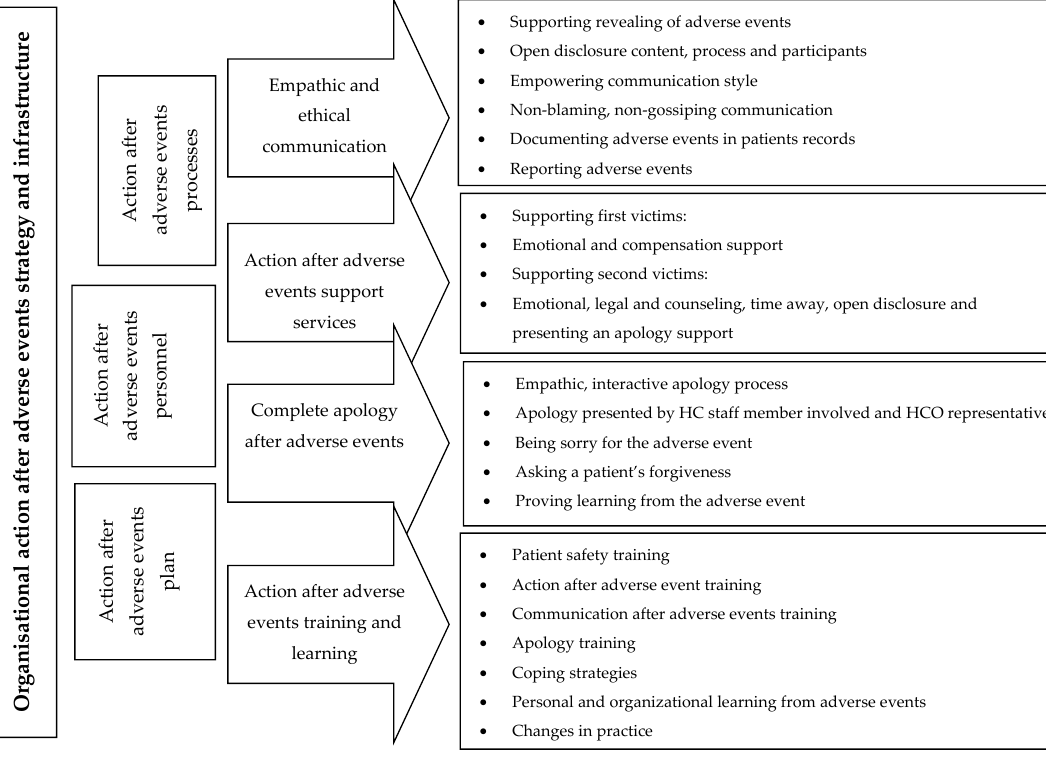
Figure 2. “Action after adverse events” in healthcare